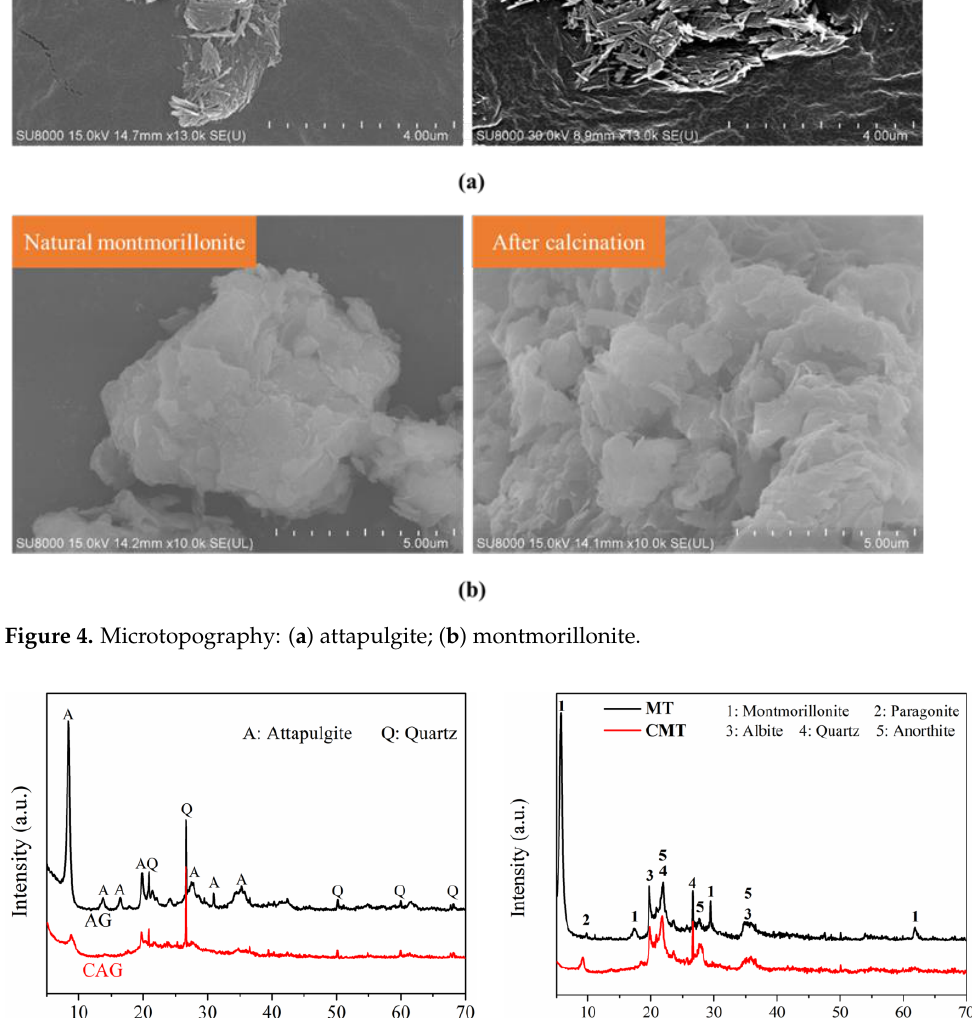
Figure 6. Effects of different contents of attapulgite and montmorillonite on the fluidity of cement paste before and after calcination: ( a ) attapulgite; ( b ) montmorillonite. In the AG/CAG group, the clean cement paste system without CAG could be auto- matically amortized, and the fluidity reached 245 mm during the test. As the AG content increased to 1 wt%, the fluidity of the cementing material decreased sharply to 60 mm and remained stable then, which was attributed to the fact that AG would absorb a large amount of water-reducing agent in the mixing process so that it could not be well dis- persed in the system or play the role of water reducing, and due to the unique pore struc- ture of AG, it would further absorb the free water content of the slurry, thereby resulting in a significant reduction in the fluidity of mixed cement paste [24]. Similarly, when 1 wt%